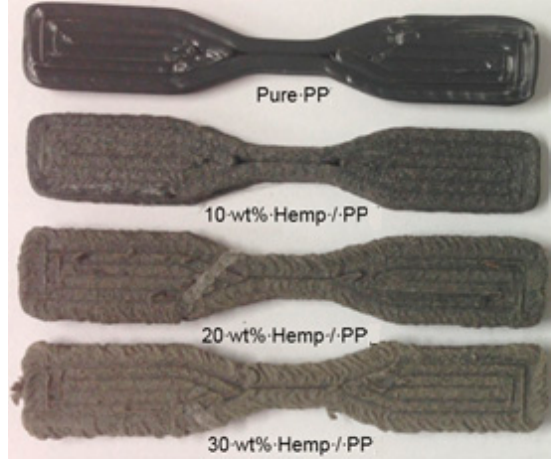
Figure 6. Surface finish of hemp/polypropylene dog bone specimens.